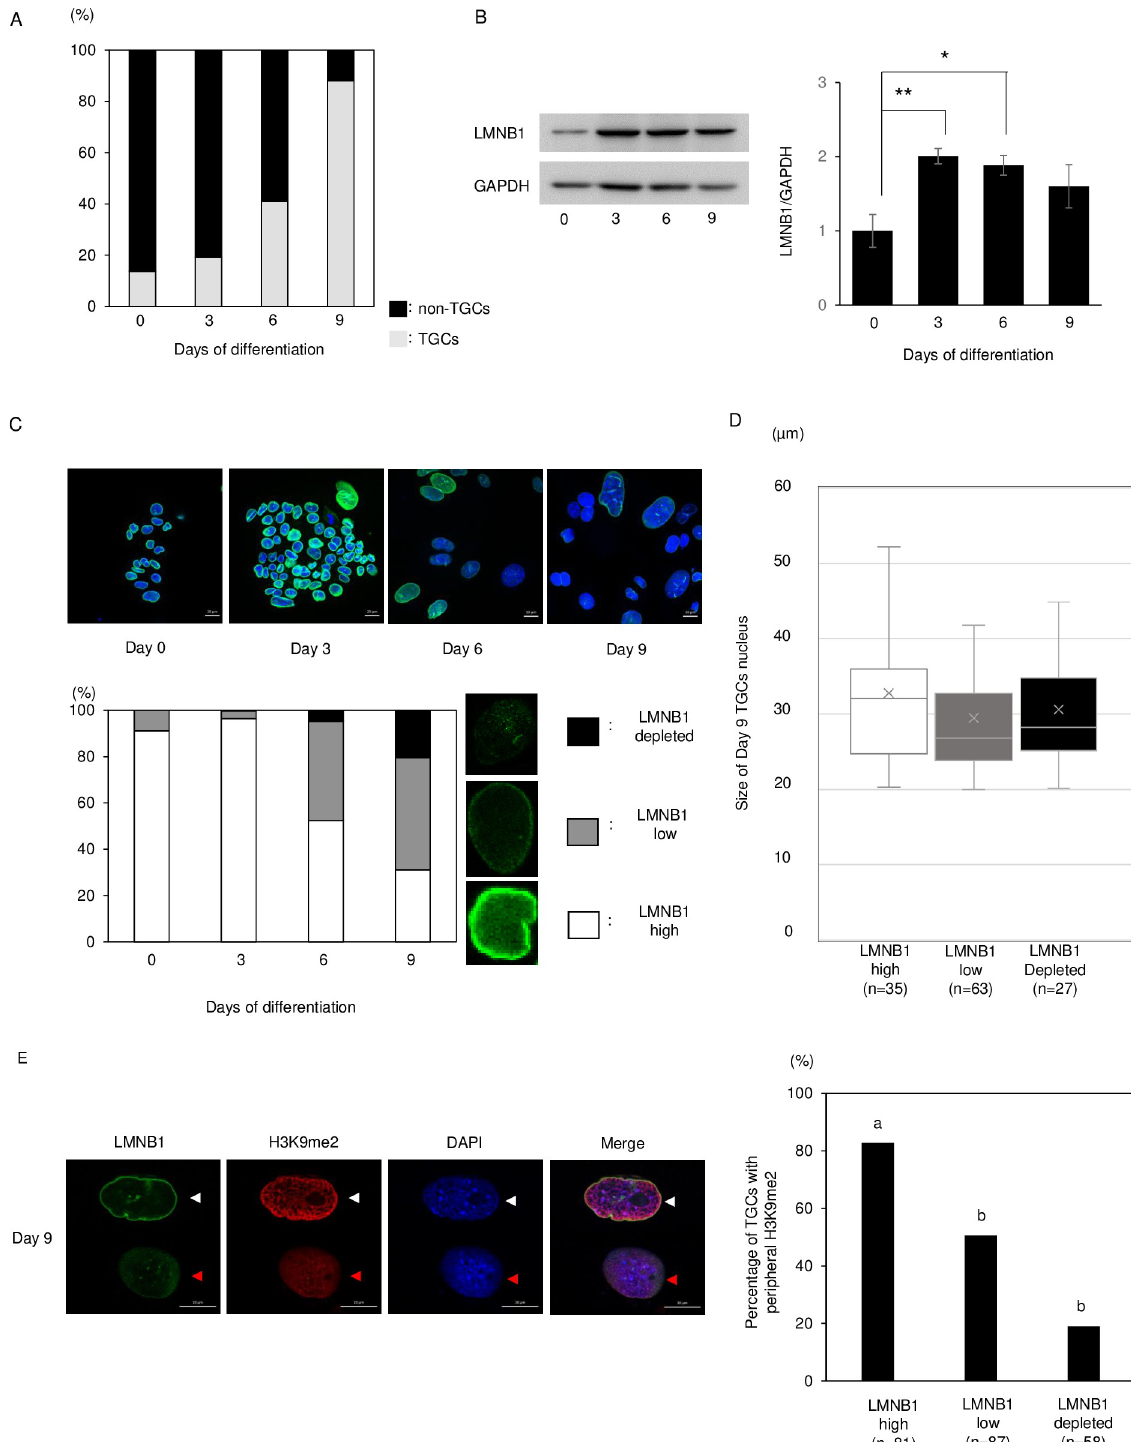
Fig 3. Localization of LMNB1 during TGC formation. (A) Percentages of TGCs at days 0–9 after differentiation. The percentage of TGCs dramatically increased from days 6 to 9. (B) Western blot analysis of LMNB1 at days 0–9 after differentiation. The amount of LMNB1 protein peaked at day 3 and then gradually decreased. The data are represented as means ± SE (n = 5). Significance was determined by the t-test as a comparison between day0 and each day after differentiation. � Indicates P < 0.05, �� indicates P < 0.01. (C) Localization of LMNB1 at days 0–9 after differentiation. Although almost all cells were LMNB1-high at day 0, 50% and 20% were LMNB1-low and -depleted, respectively, at day 9